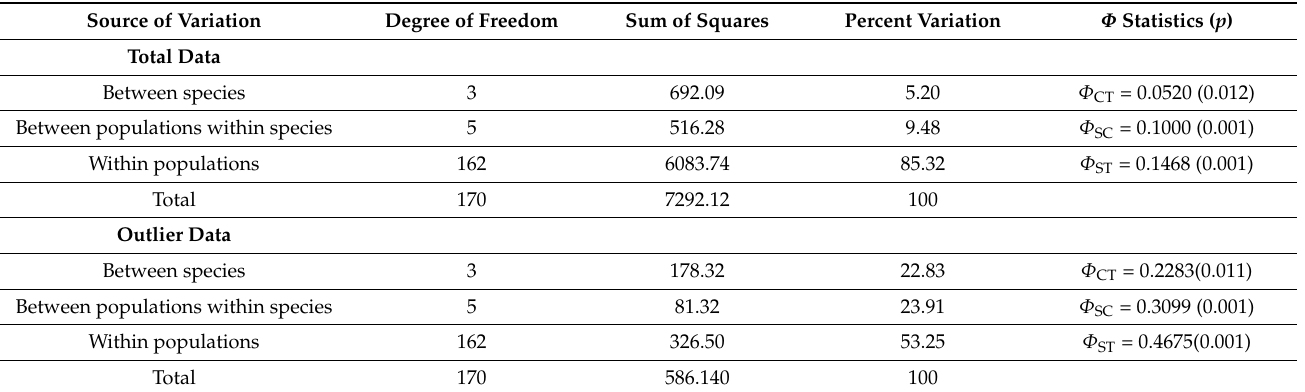
Table 2. Genetic differentiation between species, between populations within species, and between nine populations of the Rhododendron pseudochrysanthum complex based on the total and outlier AFLP variation using analysis of molecular variance